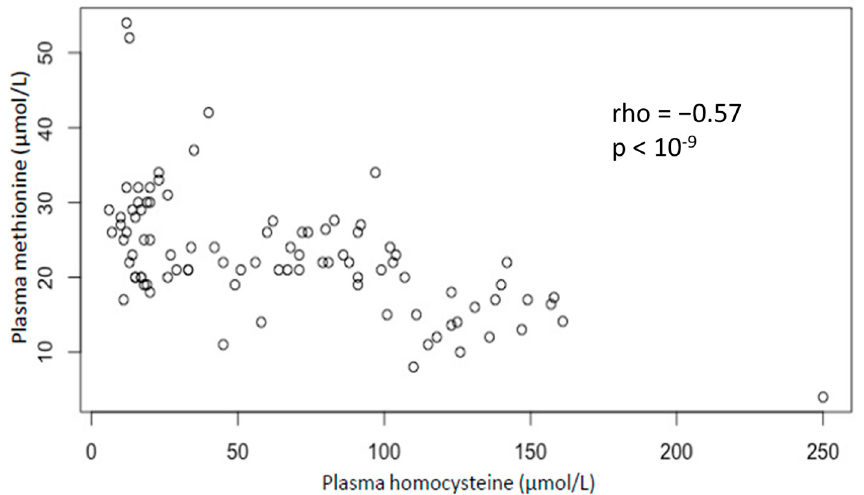
Figure 2. Plasma Methionine according to plasma Homocysteine. Groups are based on the severity of their clinical symptoms (based on Peripheral Neuropathy Disability (PND) score: level 0: no symptoms; level 1: paresthesia or PND I; level 2: gait disorders or PND II; level 3: thrombosis or combined subacute degeneration of spinal cord or PND III or IV. p -value and rho were obtained by non-parametric Spearman rank